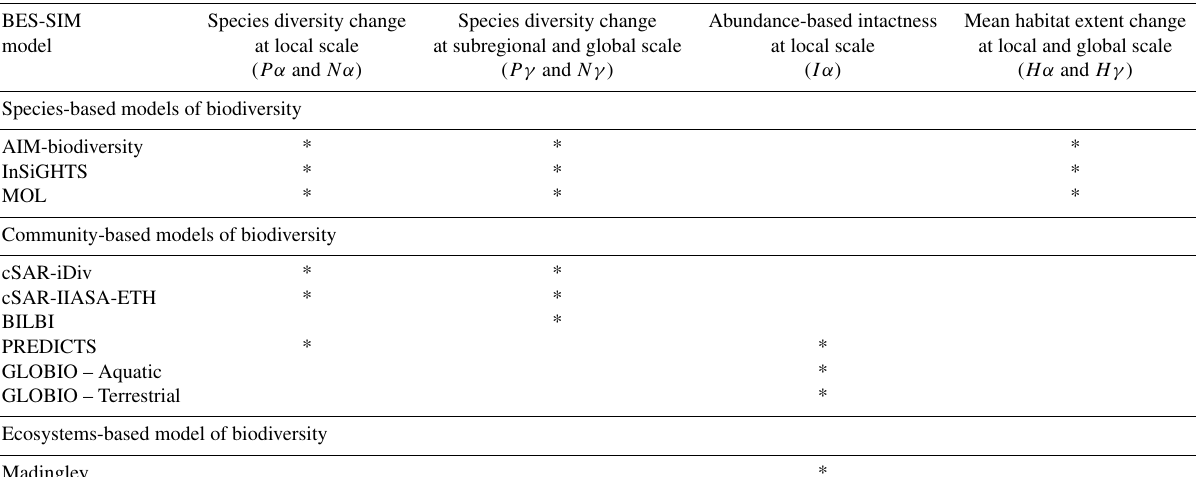
Table 4. Selected output indicators for intercomparison of biodiversity and ecosystems models. For species diversity change, both propor- tional changes in species richness ( P ) and absolute changes ( N ) are reported. Some models project the α metrics at the level of the grid cell (e.g., species-based and SAR based community models) while others average the local values of the metrics across the grid cell weighted by the area of the different habitats in the cell (e.g., PREDICTS, GLOBIO).